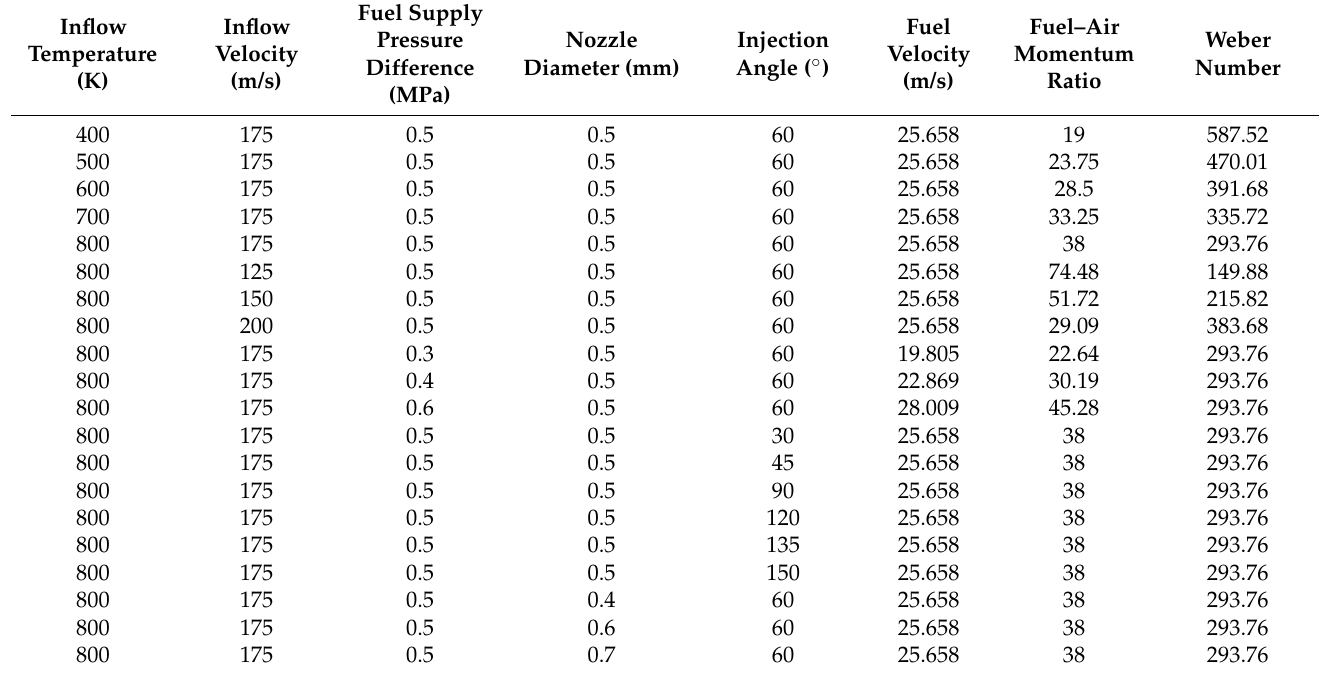
Table 2. Calculation conditions of the parameters affecting the jet